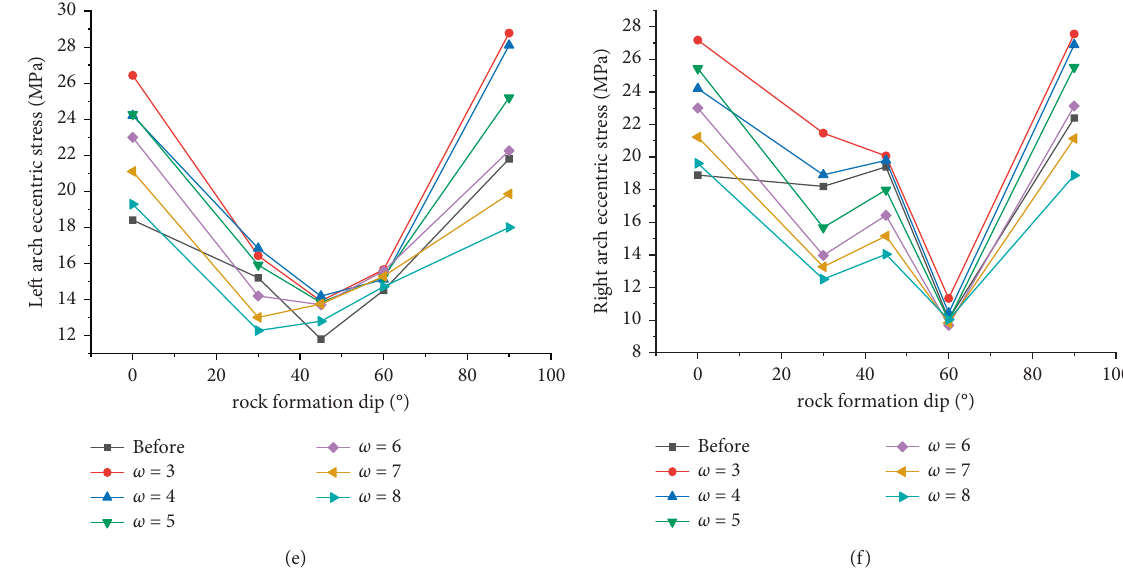
Figure 15: Effect of slope coefficients on the deviatoric stress of key points. (a) Simulation values of the eccentric stress of the vault under different slope coefficients. (b) Simulation values of the eccentric stress of the arch bottom under different slope coefficients. (c) Simulation values of the eccentric stress of the left arch shoulder under different slope coefficients. (d) Simulation values of the eccentric stress of the right arch shoulder under different slope coefficients. (e) Simulation values of the eccentric stress of the left arch foot under different slope coefficients. (f) Simulation values of the eccentric stress of the right arch foot under different slope